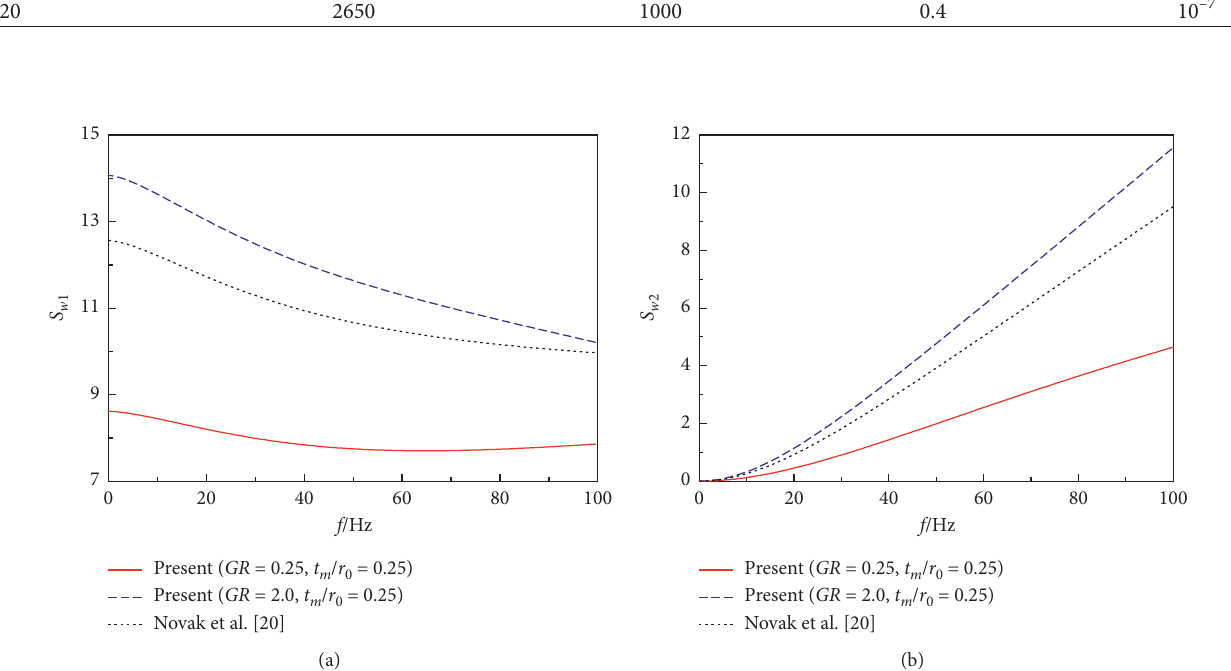
Figure 3: Comparison of the present reduced single-phase medium solution with the homogeneous medium solution ( D r 0 � 0.3m).